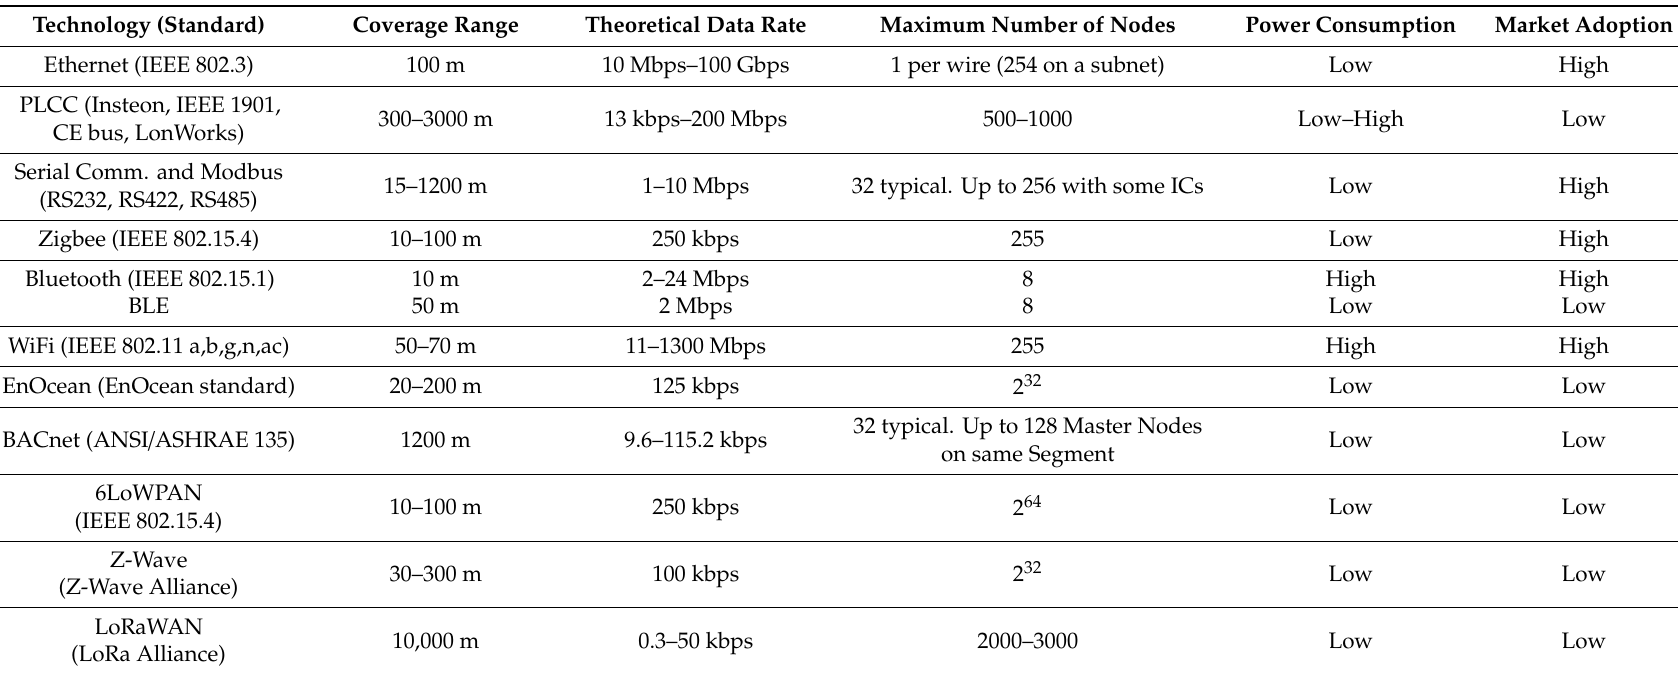
Table 3. Key characteristics of prominent wired and wireless technologies for building